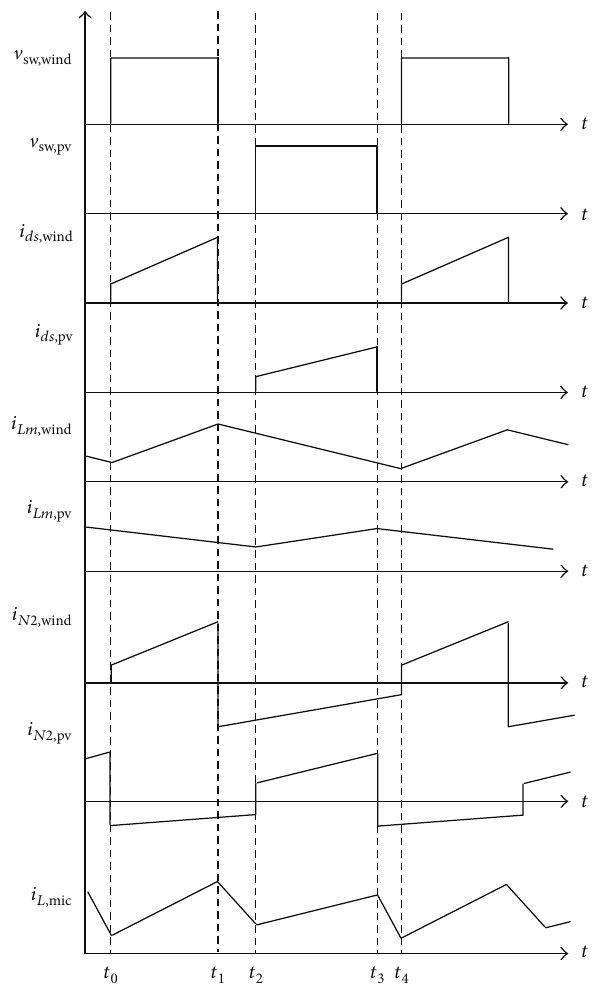
Figure 6: Conceptual key waveforms of the proposed